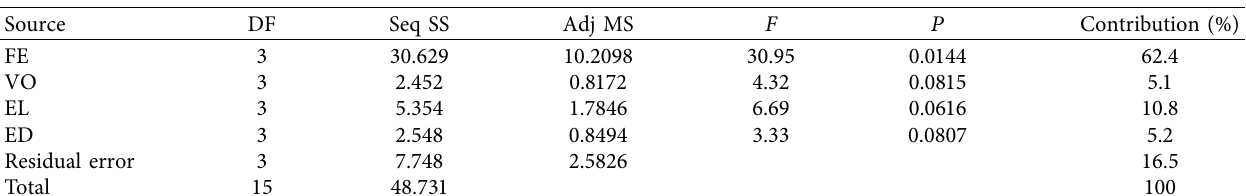
Figure 7: SN ratio plot for SR. Table 9: ANOVA for SR.